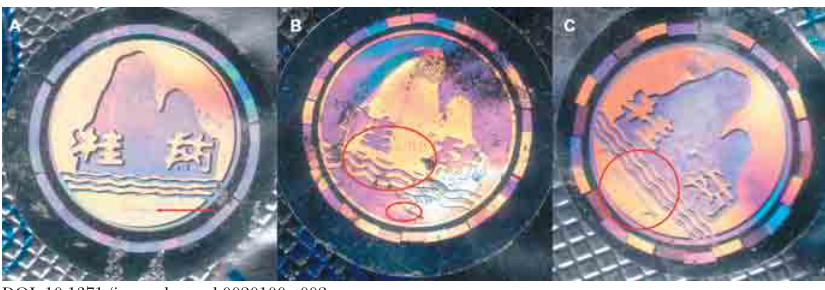
Figure 2. Genuine and Fake Guilin Pharma Artesunate Blister Pack Holograms Found in Mainland Southeast Asia (A) is the genuine hologram attached to the blister packs of the genuine Guilin Pharma artesunate. The red arrow points to a legend stating “GUILIN PHARMA”, which is visible with the naked eye as a thin strip below the waves, but can only be read with a microscope (letters are about 0.1 mm high). (B) is a fake artesunate blister pack hologram: the upper red ring shows that the hologram has crescents, rather than a continuous blank line, between mountain and waves, and the lower ring shows that there is no “GUILIN PHARMA” legend. (C) is also a fake artesunate blister pack hologram: the red ring shows that the